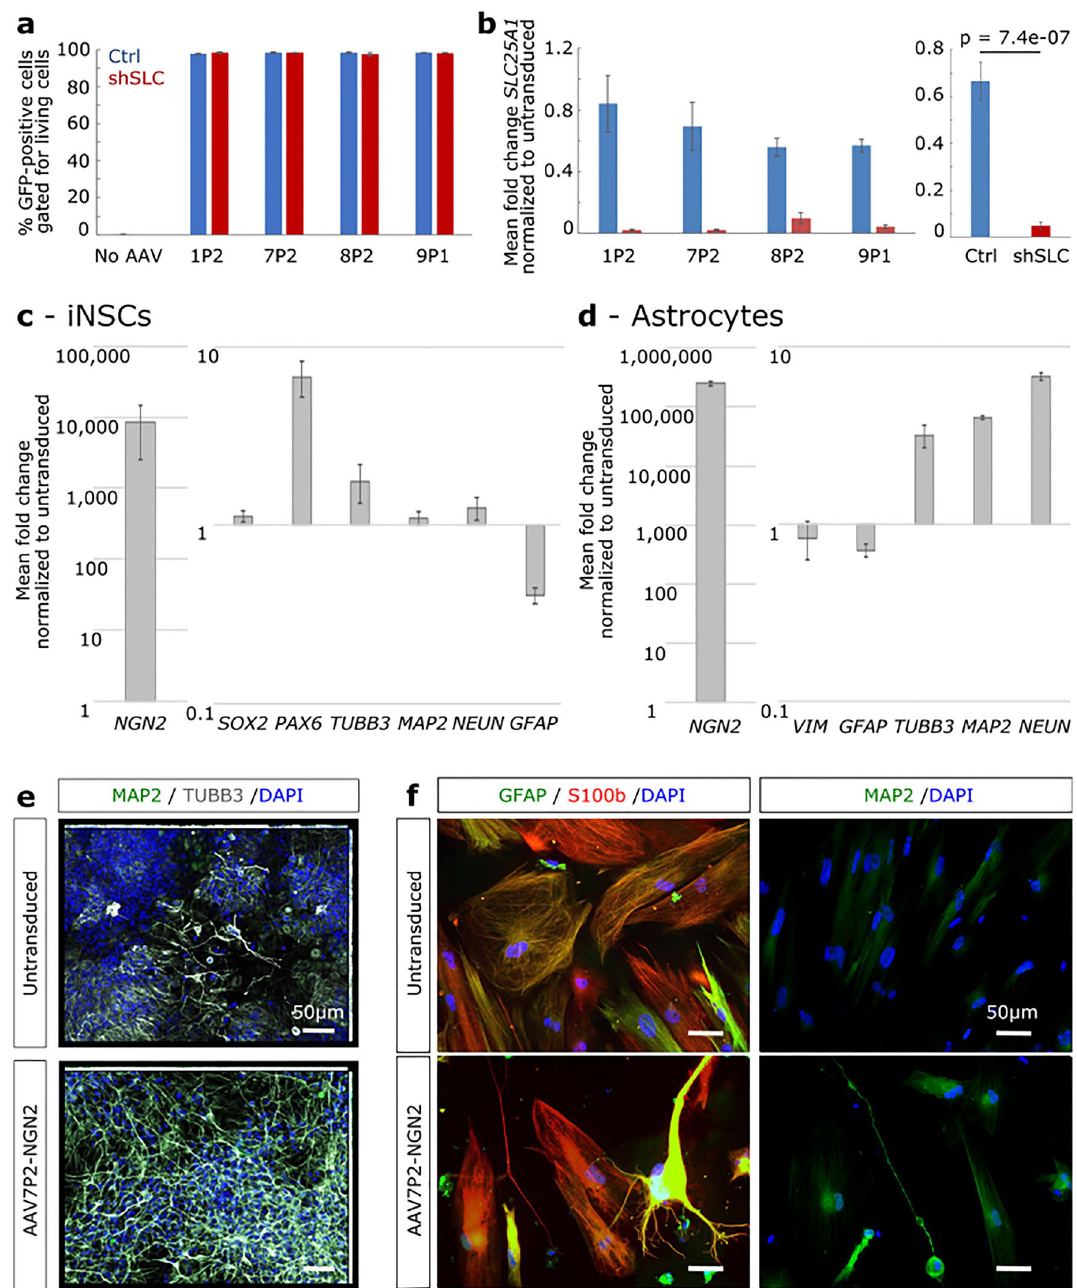
Figure 2. AAVs selected from the screen are capable of achieving shRNA-mediated gene knockdown and transgene overexpression in iNSCs and astrocytes. ( a ) Transduction efficiencies in iNSCs with crude lysates of the lead candidate AAV variants AAV1P2, 7P2, 8P2 and 9P1 expressing GFP along with shRNA- SLC25A1 (shSLC) or a non-silencing control shRNA (Ctrl). Bar graph represents means ± standard error from N = 3 independent experiments per condition. ( b ) Expression of SLC25A1 as measured by qPCR. Bar graph represents means ± standard error from N = 3 independent experiments per condition. The graph’s left panel depicts the individual data of all AAV variants tested here, whilst the panel on the right depicts the means of all Ctrl and shSLC vectors. Wilcoxon rank sum test was performed on the pooled dataset. ( c , d ) qPCR-based expression profiling of neuronal and glial markers after fourteen days of AAV7P2-mediated NGN2 overexpression in spontaneously differentiating iNSCs ( c ) and iPSC-derived astrocyte cultures ( d ). Bar graphs represent means ± standard error of N = 4 from 2 independent experiments. ( e , f ) Exemplary images of immunofluorescence stainings against neuronal and/or glial markers in NGN2-transduced and untransduced, differentiating iNSCs ( e ) and iPSC-derived astrocyte cultures ( f